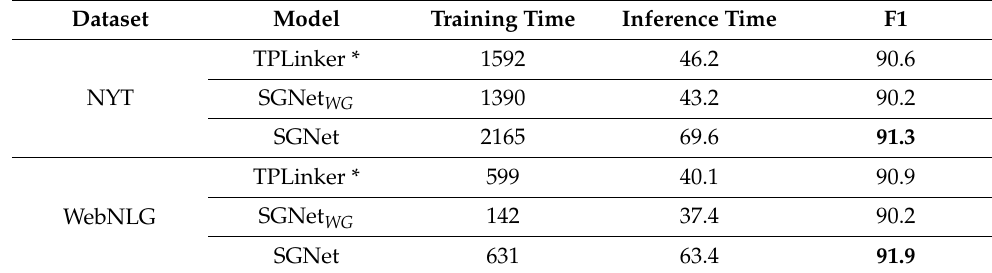
Table 5. Comparison of the model efficiency. Training time(s) means the time required to train one epoch, and inference time (ms) is the time to predict triples of one sentence. Our re-implementation is marked by